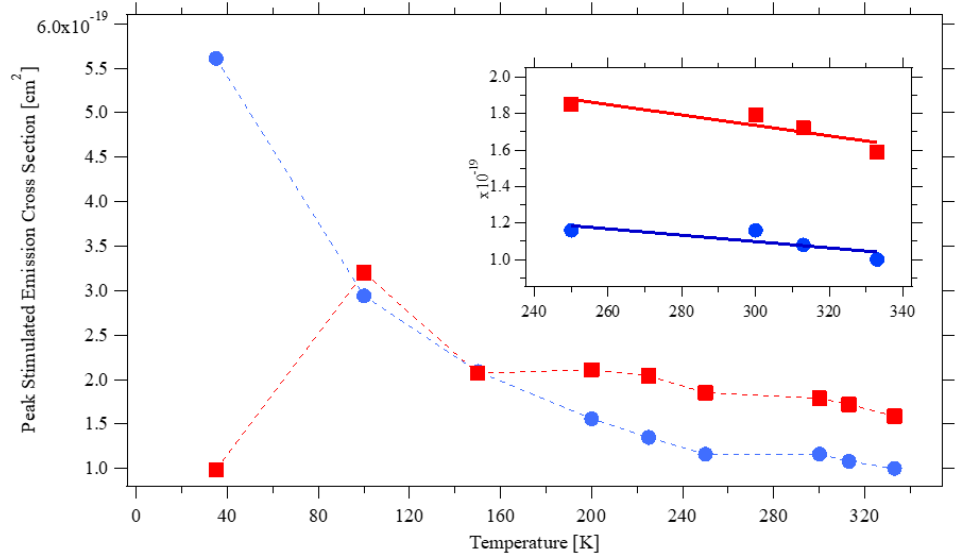
Figure 5. Stimulated emission cross-section for the peak emission at ~1047 nm (π-polarization, red) and at ~1053 nm (σ-polarization, blue) as a function of the temperature. The full lines in the inset are a linear best-fit in the 250 K–350 K temperature range.